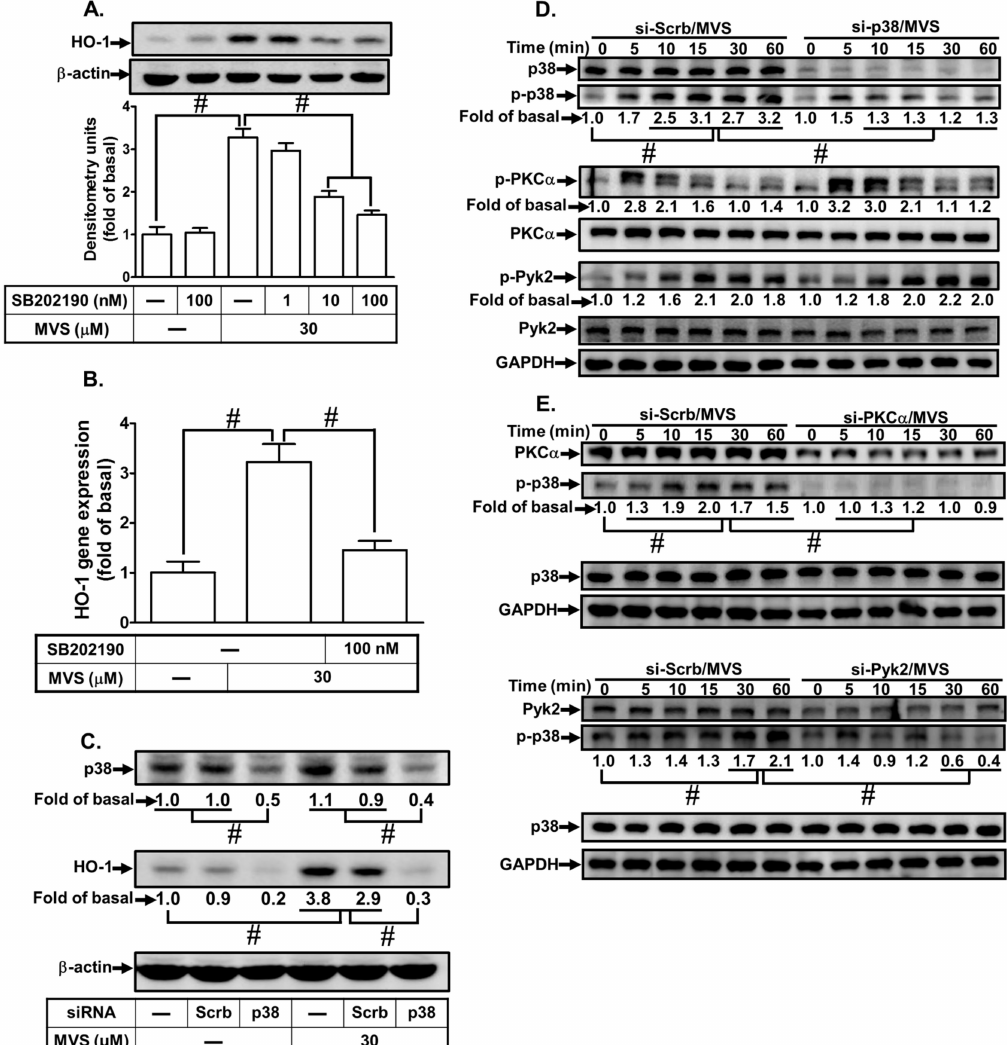
Figure 4. p38 MAPK is involved in the MVS-induced HO-1 expression. ( A ) HPAEpiCs were pretreated with various concentrations of SB202190 for 1 h, and then incubated with vehicle or MVS (30 µ M) for 24 h. The levels of HO-1 and β -actin protein expression were determined by Western blot. ( B ) The cells were pretreated with SB202190 (100 nM) for 1 h and then incubated with MVS for 8 h. The levels of HO-1 mRNA were analyzed by real-time qPCR. ( C ) Cells were transfected with scrambled (Scrb) or p38 MAPK siRNA, and then incubated with MVS for 24 h. The levels of p38 MAPK, HO-1, and β -actin protein expression were determined by Western blot. ( D , E ) HPAEpiCs were transfected with scrambled (Scrb), PKC α , Pyk2, or p38 MAPK siRNA and then incubated with MVS for the indicated time intervals. The levels of phospho-p38 MAPK, p38 MAPK, phospho-PKC α , PKC α , phospho-Pyk2, Pyk2, and GAPDH were determined by Western blot using respective antibodies. Data are expressed as mean ± SEM of five independent experiments ( n = 5). # p < 0.01, as compared with the cells exposed to the indicated